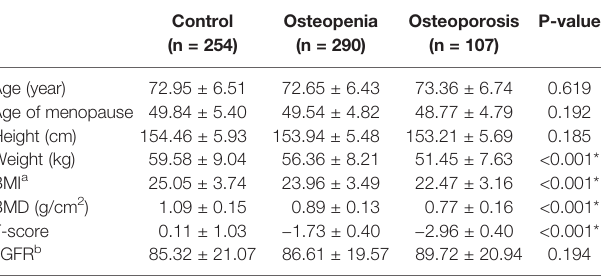
TABLE 1 | Characteristics of participants in case-control